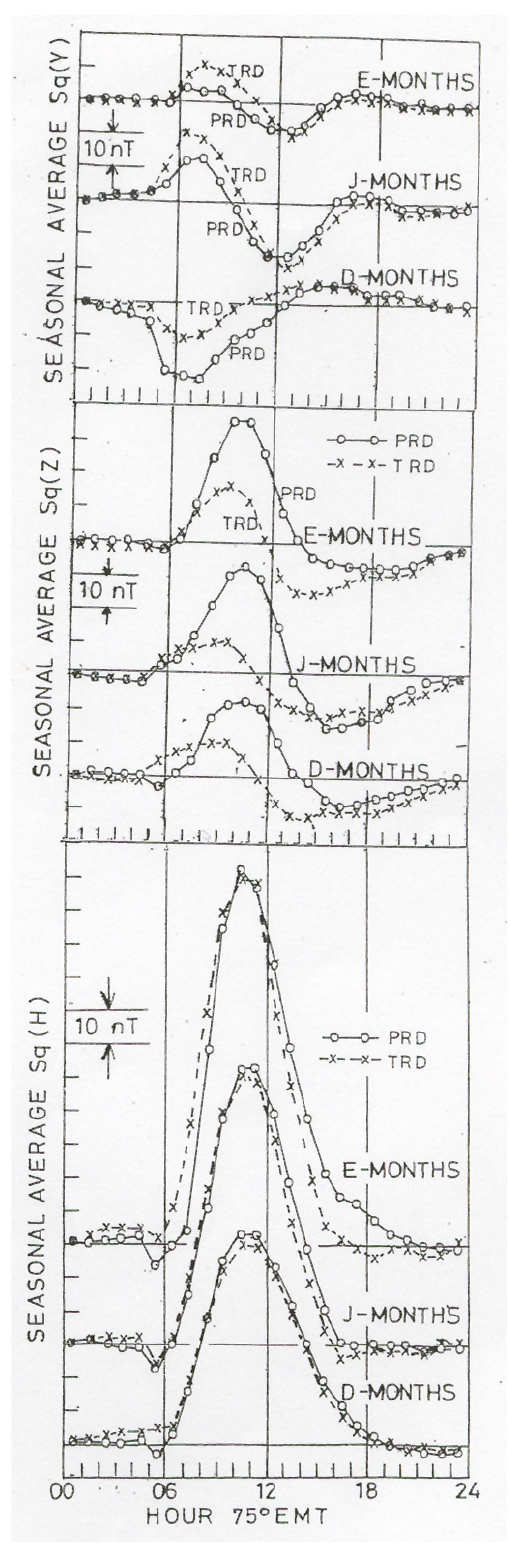
Fig. 6. Seasonal average daily variations of H , Y and Z fields at Peredinia and Trivandrum, during the period March 1993–February